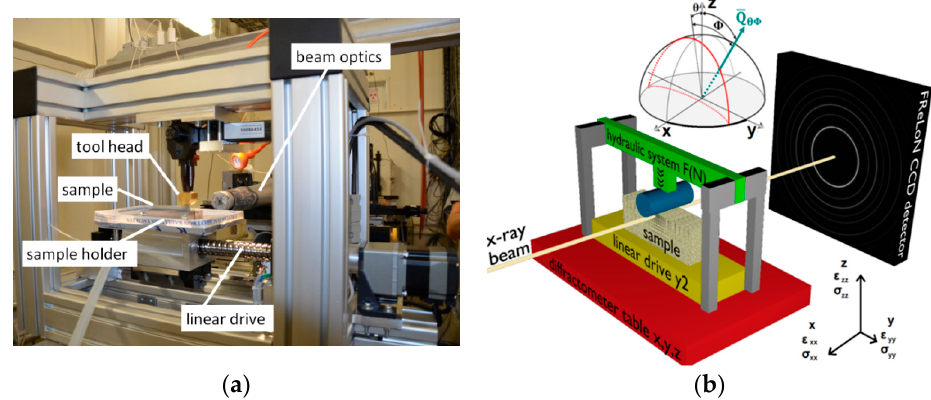
Figure 1. Deep rolling frame mounted in beamline ID11 in ( a ) frontal view (detector side) and ( b ) sketch of the experimental setup and scanning geometry [6,7].